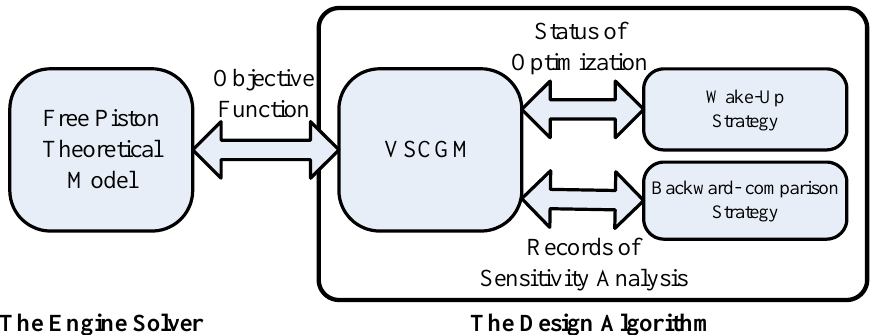
Figure 2. Design algorithm combining theoretical model and design algorithm for free-piston Stirling engine optimization.